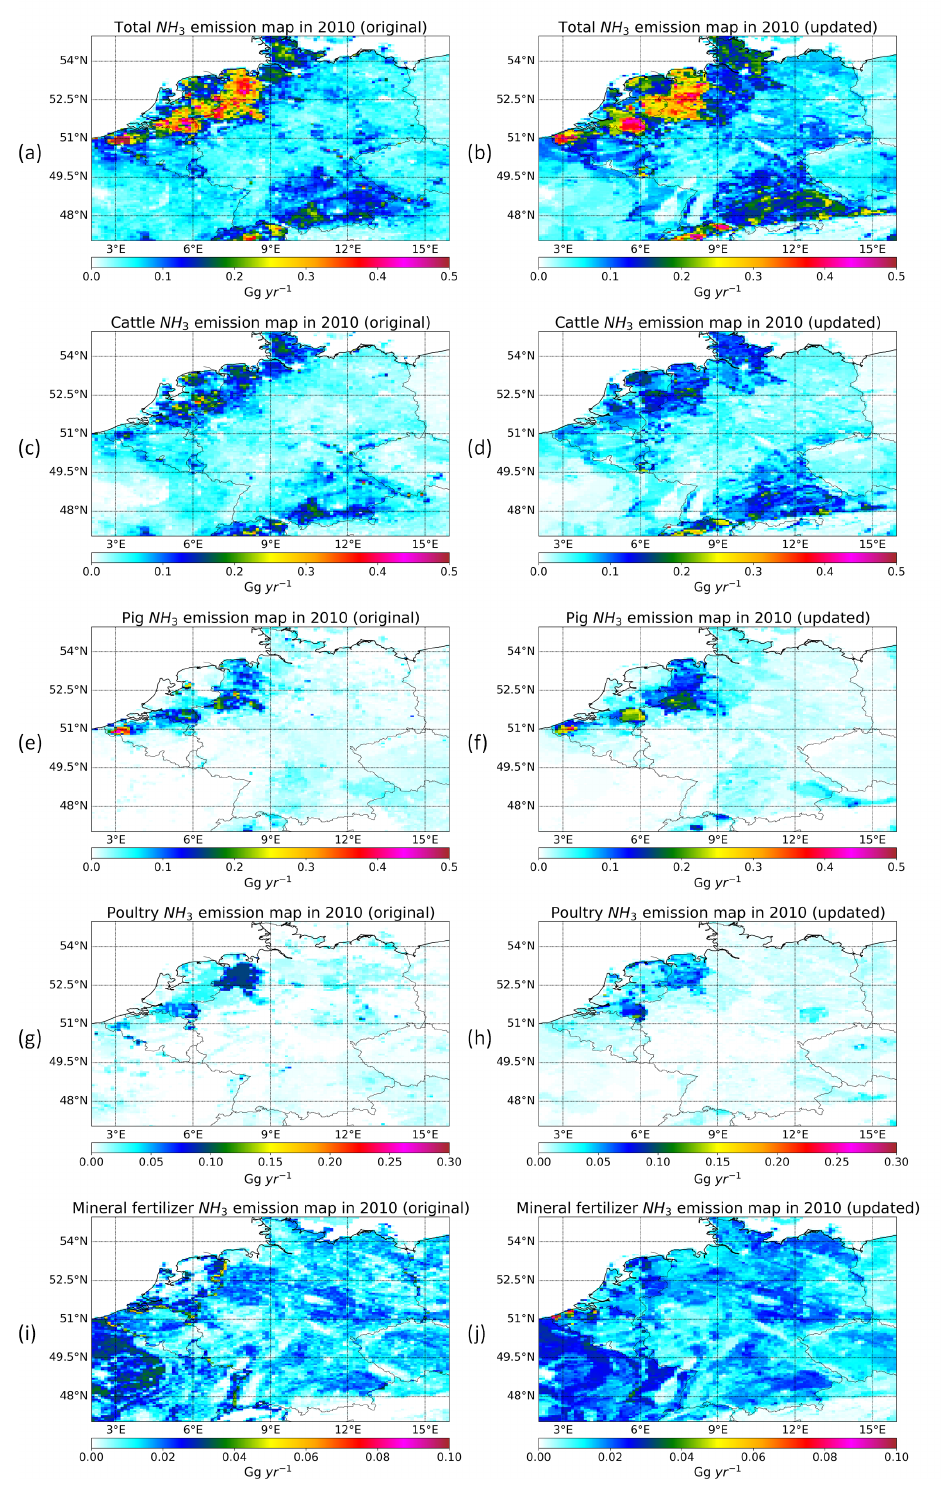
Figure 3. Maps of annual emission total (Ggyr − 1 ) for all agricultural categories and cattle, pig, poultry, and mineral fertilizer in 2010. The left panels indicate the original MACC-III inventory results, while the right panels represent the output of the updated inventory. (a,b) Emission from all agricultural sectors; (c,d) emission from cattle; (e,f) emission from pig; (g,h) emission from poultry; (i,j) emission from mineral